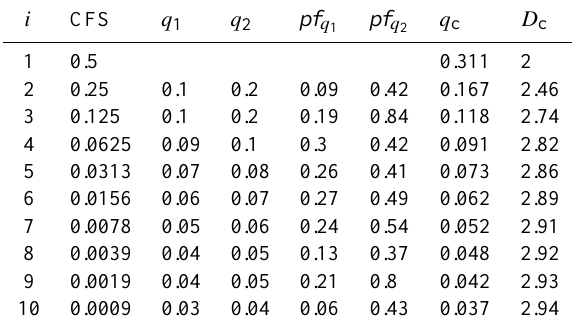
Fig. 3. Numerical experiments: Probability pf for the pore network in the fractal cube to percolate as a function of iteration level i (plotting Table 1a simulated results) for varying values of parameter q in the fractal model (and associated values of fractal dimension D and porosity calculated in Table 1b). The straight line p f = p c (Eq. 1) delimits the transition between the percolating and non percolating regimes for a random array of fractal cubes. Table 2. Critical q c estimated by a linear interpolation in the [q1, q2] interval defined by two successive yellow cells in each column of Table 1 and probabilities pf q and pf q . D c is calculated from qc 1 2 using Eq.